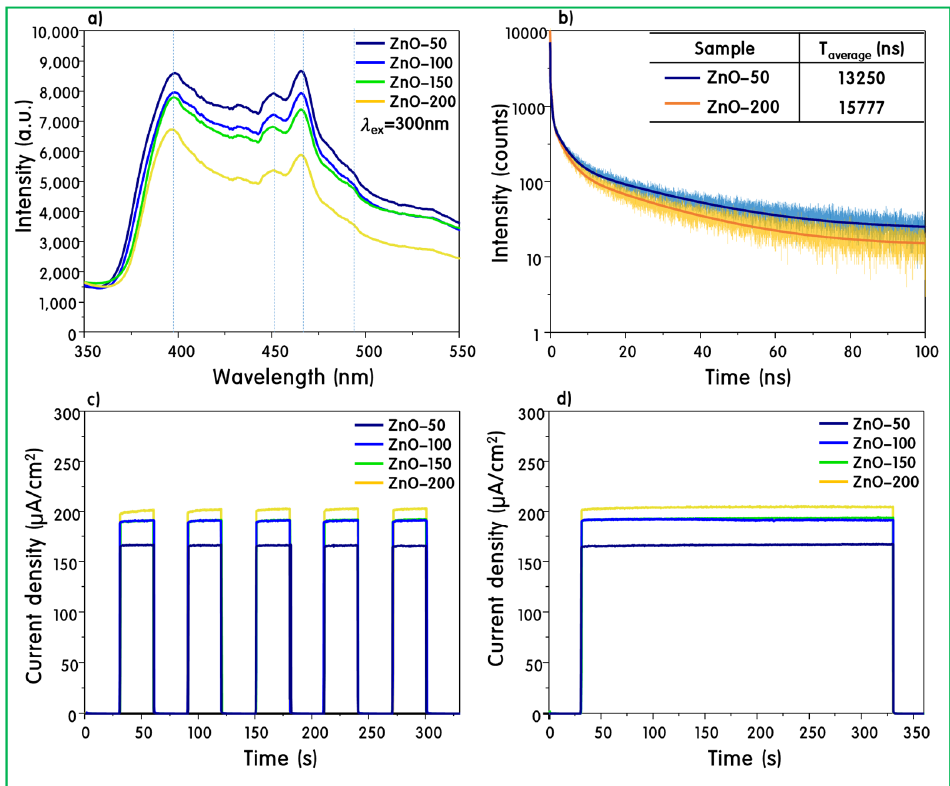
Figure 5. ( a ) PL curves. ( b ) Time-resolved PL curves for ZnO–50 and ZnO–200 nanoplates. ( c ) Photocurrent density cycle curves. ( d ) Time-resolved photocurrent density curves of synthesized ZnO nanomaterials.